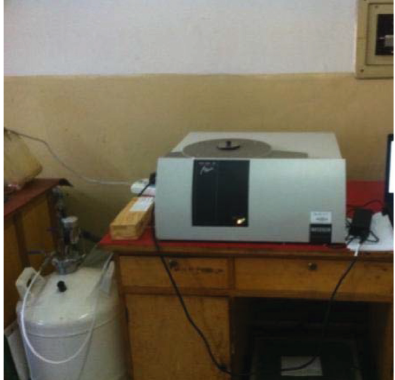
Figure 1: DSC200F3-type instrument.